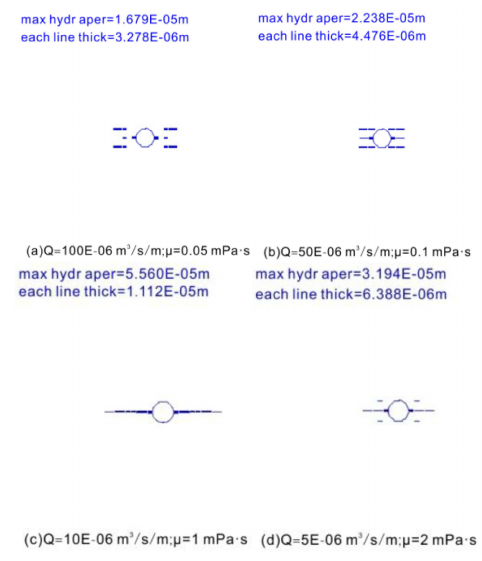
Figure 13. The relationship between hydraulic fracture geometry and Q µ .